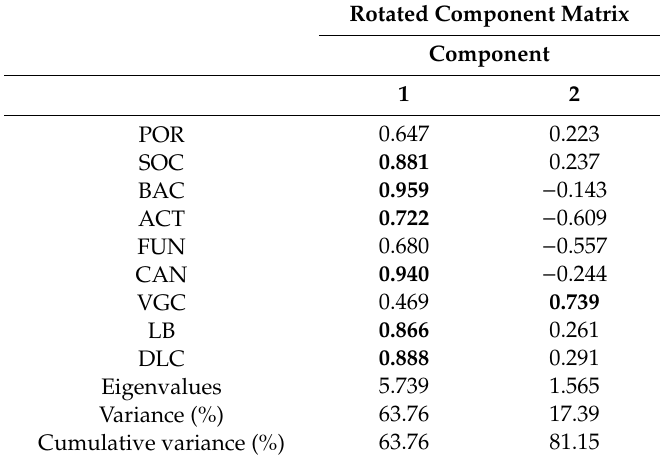
Table 2. Results of PCA. Variables bolded with absolute eigenvector coe ffi cients ≥ 0.7 are considered